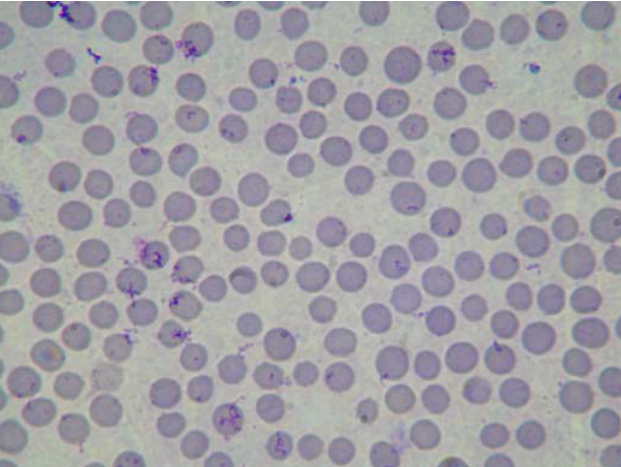
Image 1. Babesia in the red blood cells of Boselaphus